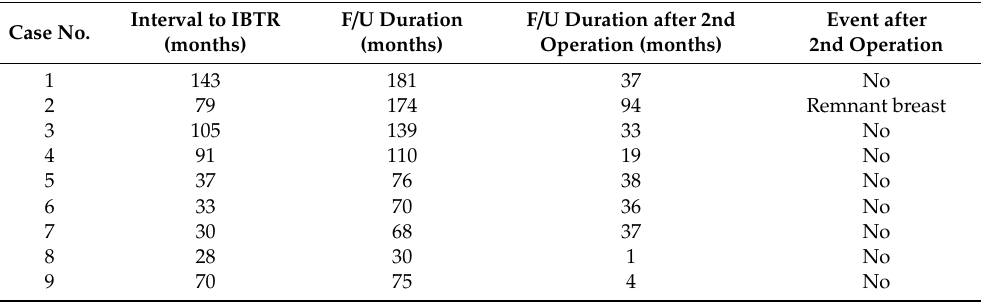
Table 3. Clinical course after the first and second